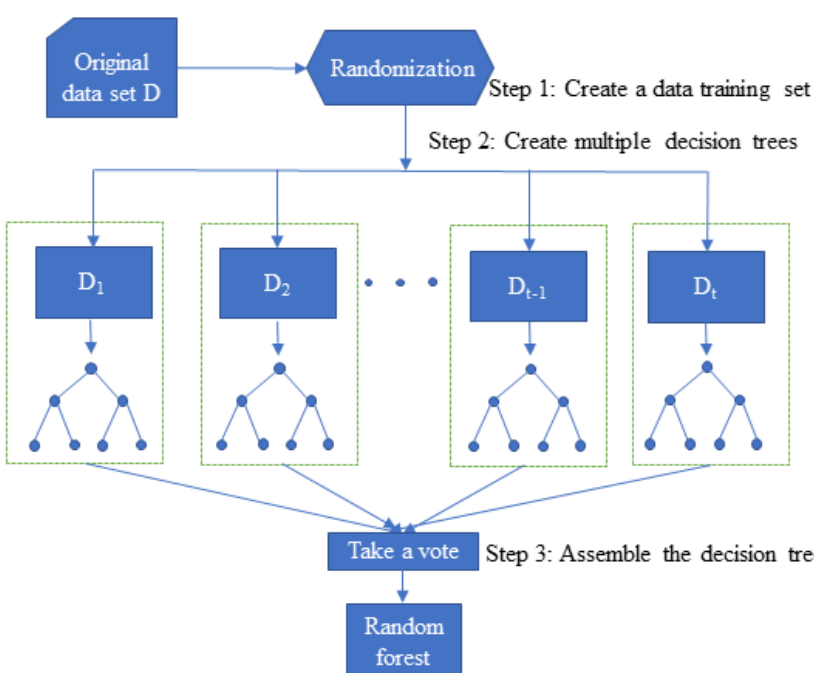
Figure 4. Flow chart of the random forest